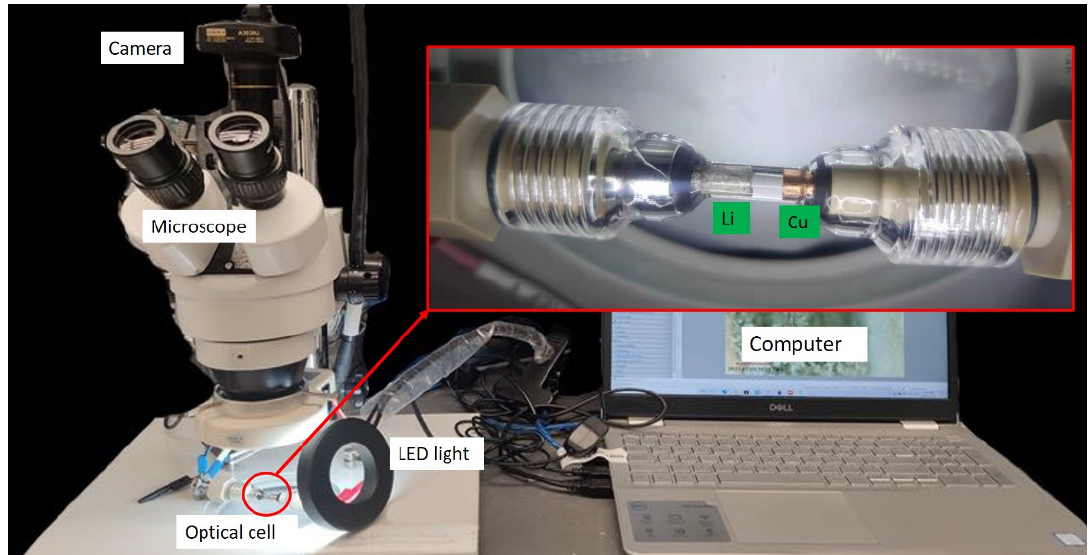
Figure 1. The setup of the optical cell test.